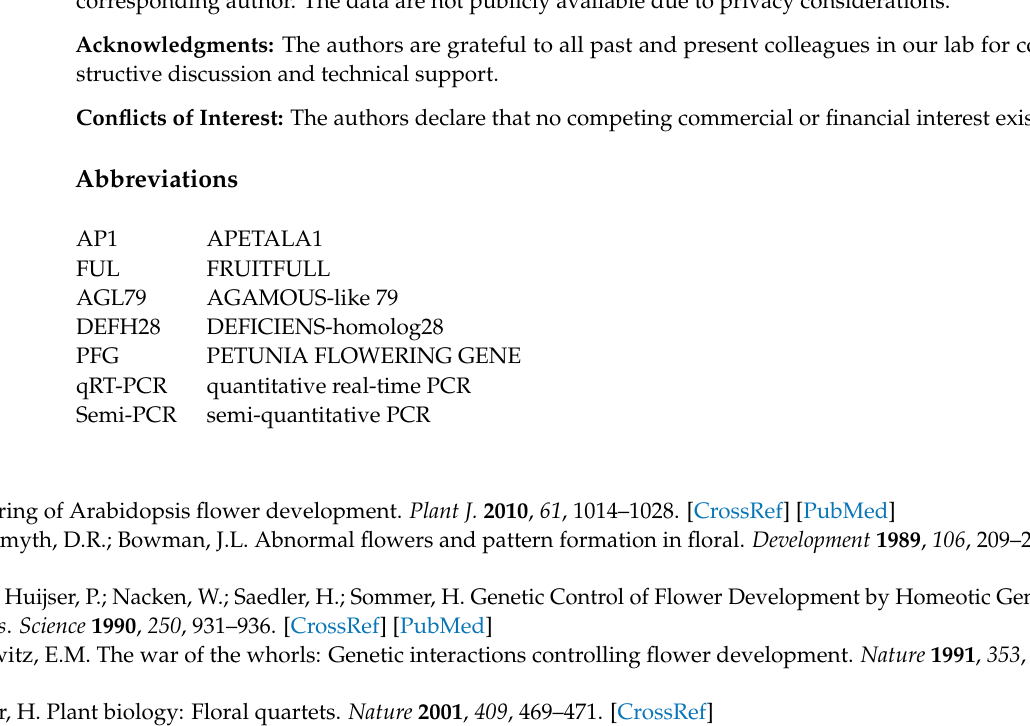
primers, Table S2: Sequence information of AP1/FUL-like proteins used to construct evolutionary tree, Table S3: Amino acid sequence alignment of TeAP1/FUL